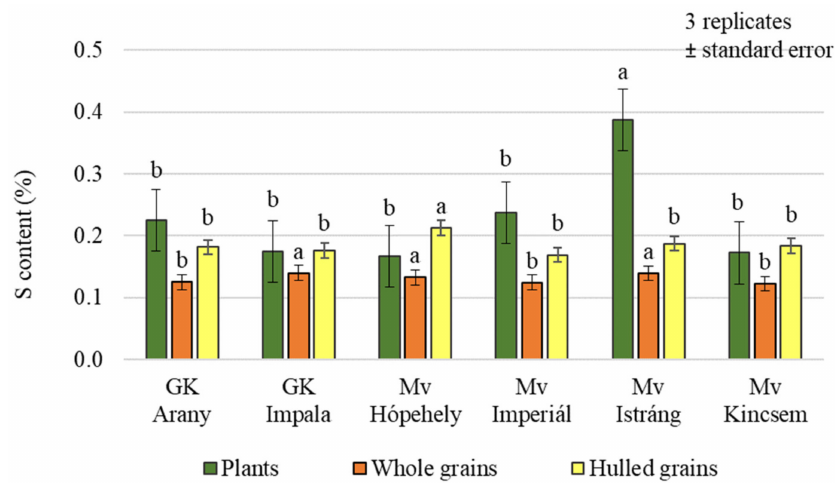
Figure 6. Sulphur content of the winter oat varieties (plants, whole and hulled grains); ± standard error of means. 3 replicates. The different letters indicate significant differences between the varieties, separately in different plant samples, at p = 0.05 level.